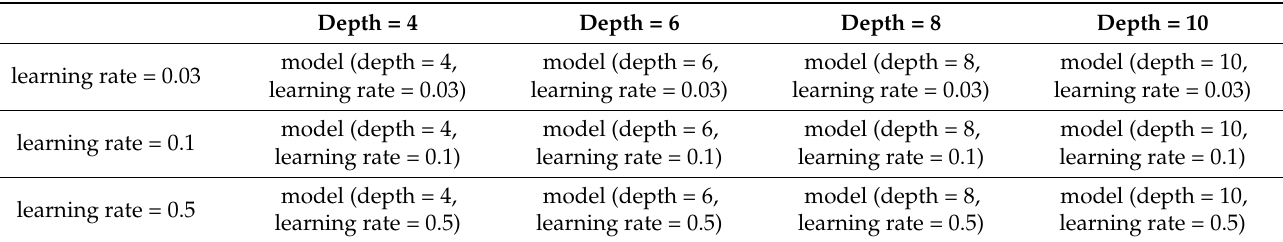
Table 3. Parameter grid for the CatBoost model.